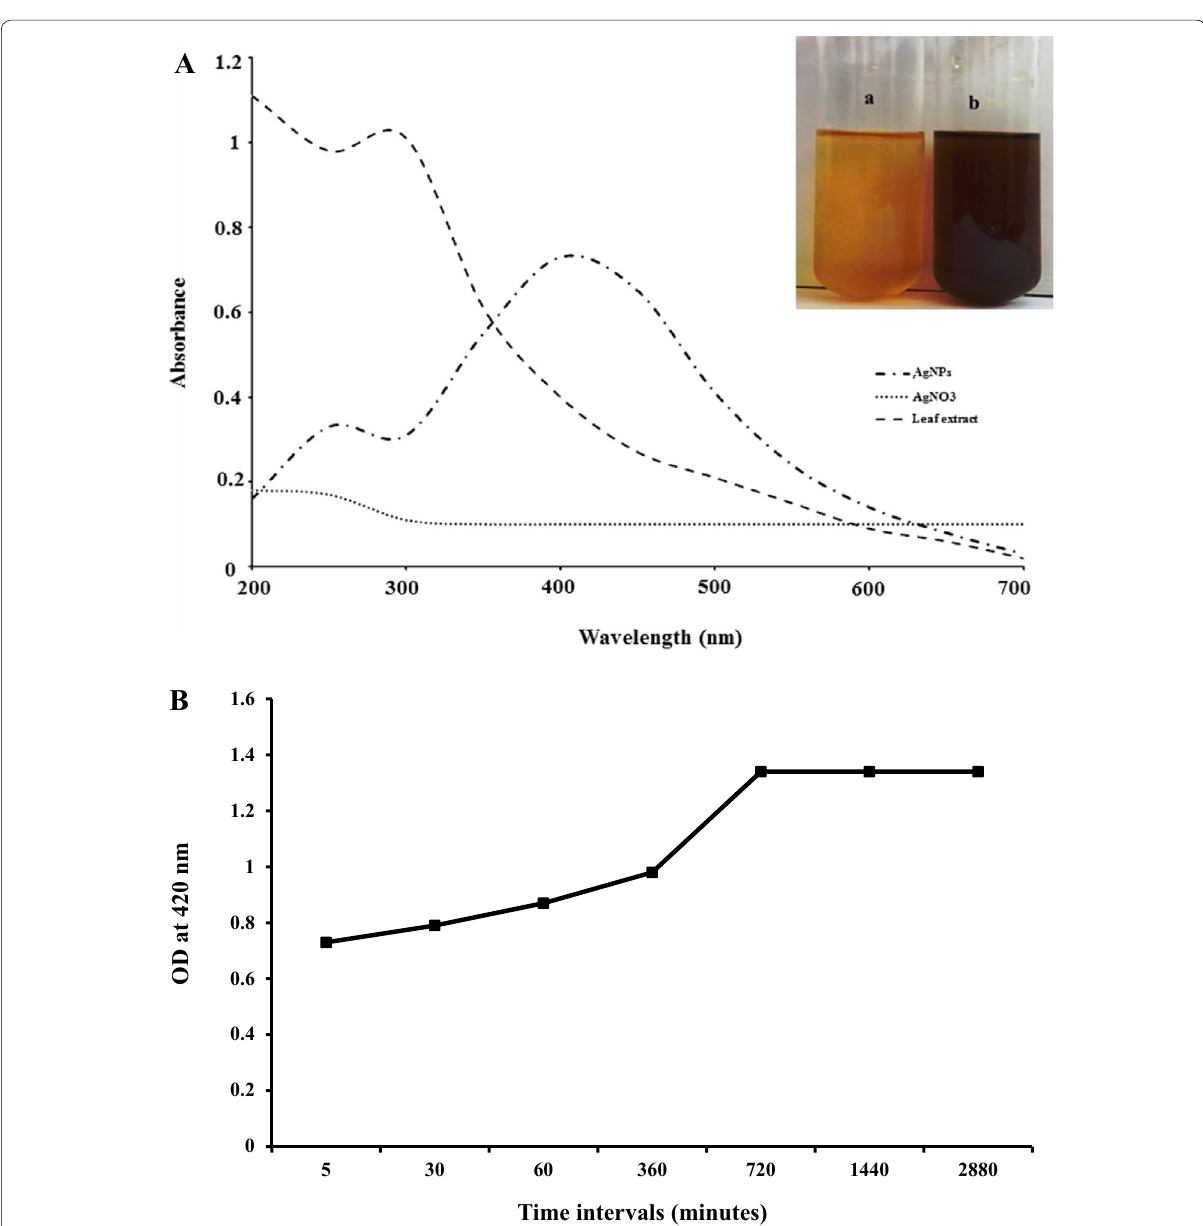
Fig. 1 A UV–Visible spectrum of synthesized silver nanoparticles [inset: change in color of the solution confirming the formation of silver nanoparticles]. (a) Plant extract and (b) synthesized silver nanoparticles. B Color intensity at 420 nm for silver nanoparticles synthesized by A. calcarata leaf extract during different time